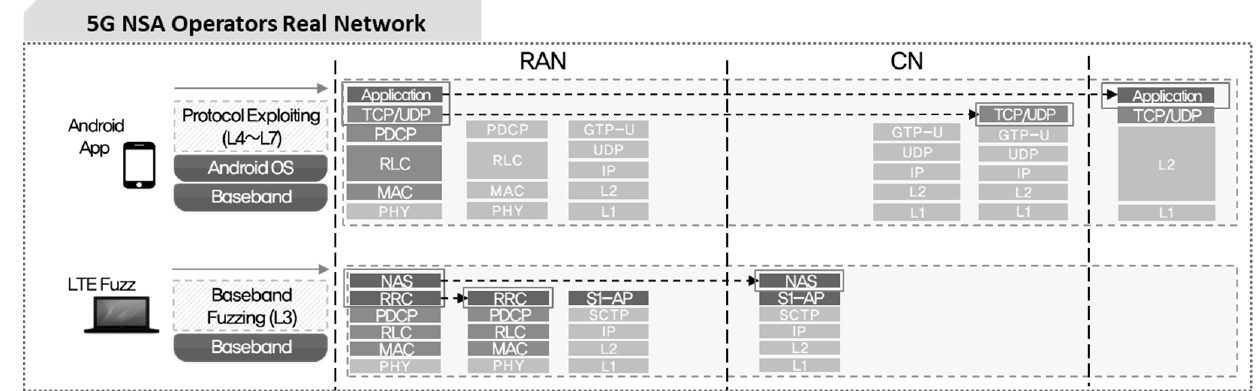
Figure 11. Testing environment for 5G security threat assessment.